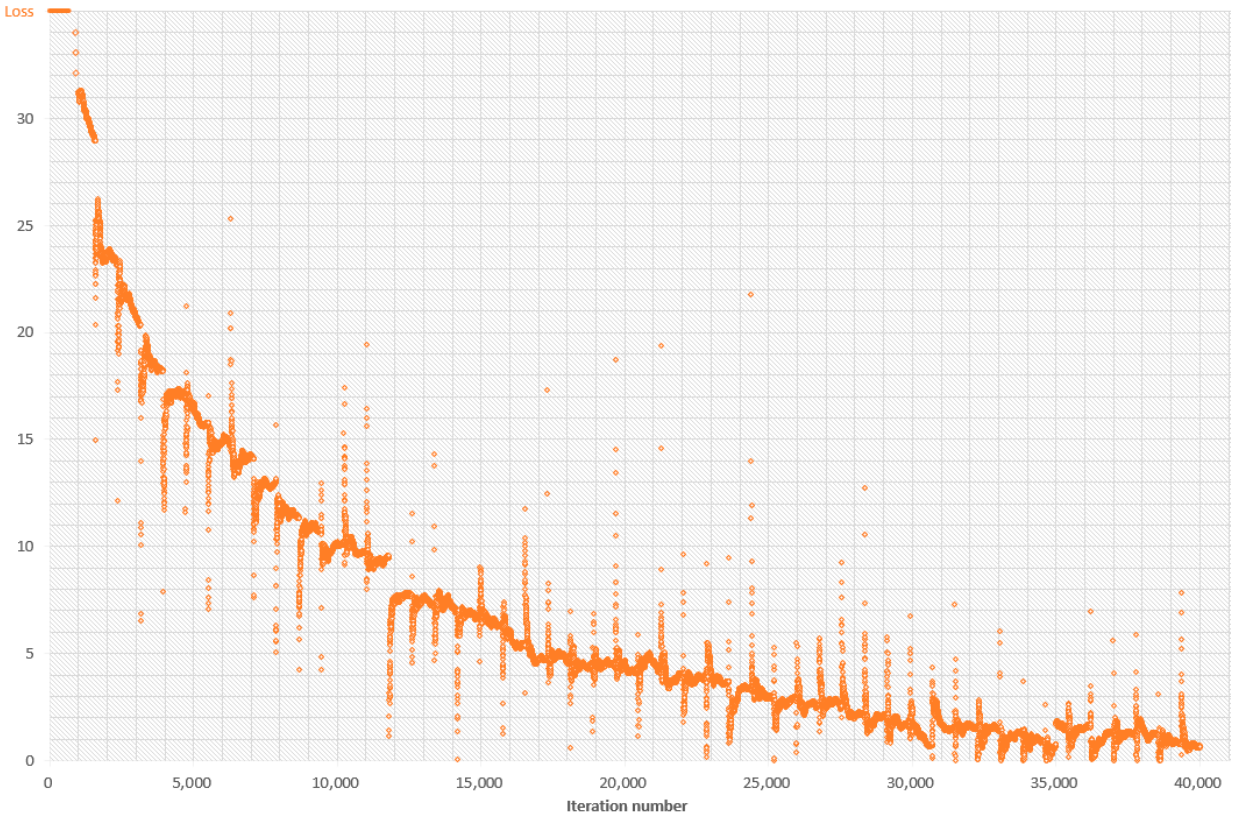
Figure 4. Training loss curve of the YOLO-V4 weed detection model.